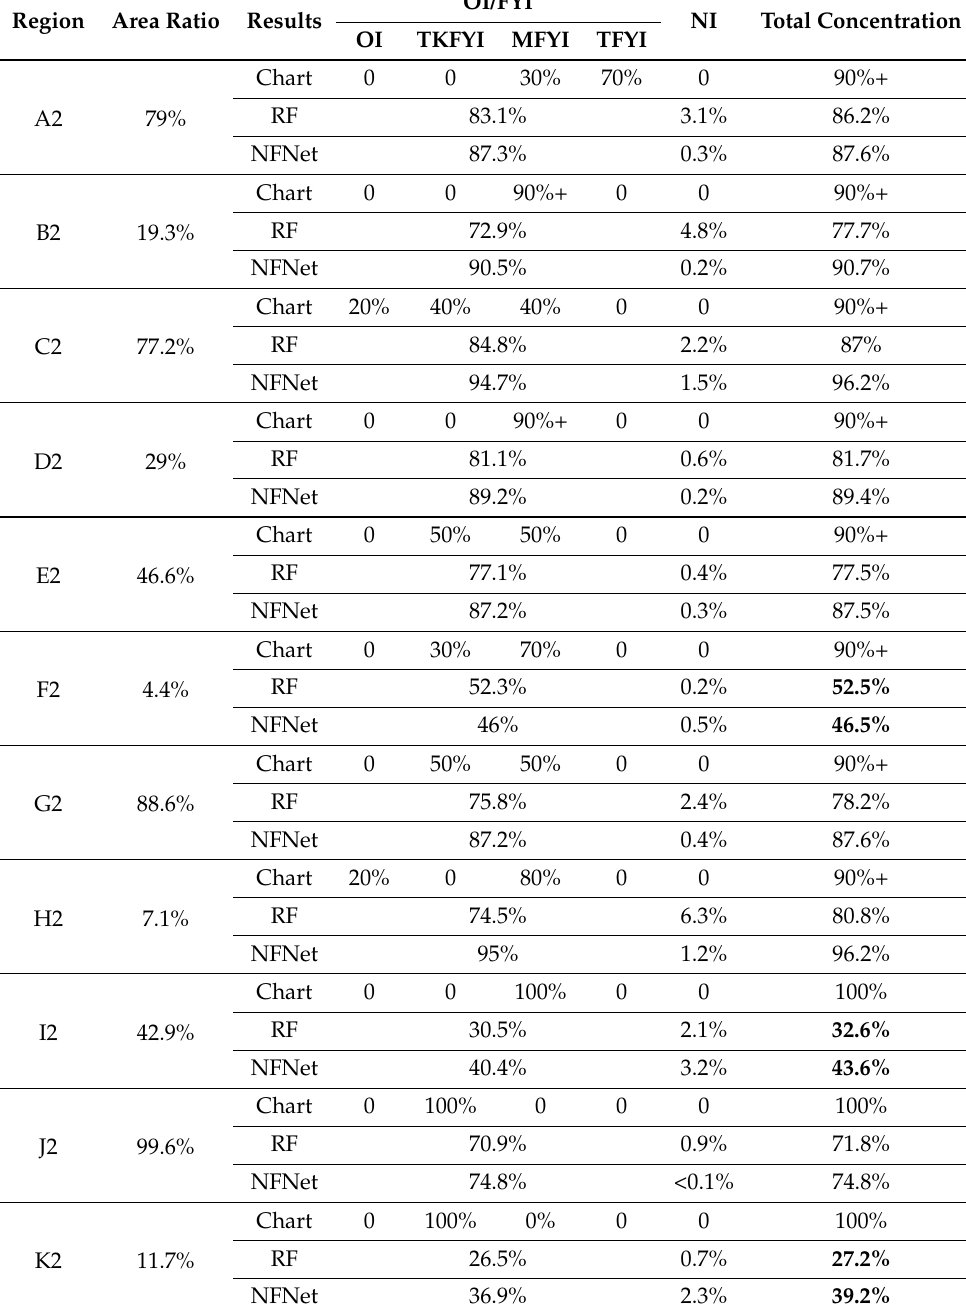
Table 6. Comparison of the estimated concentration for March